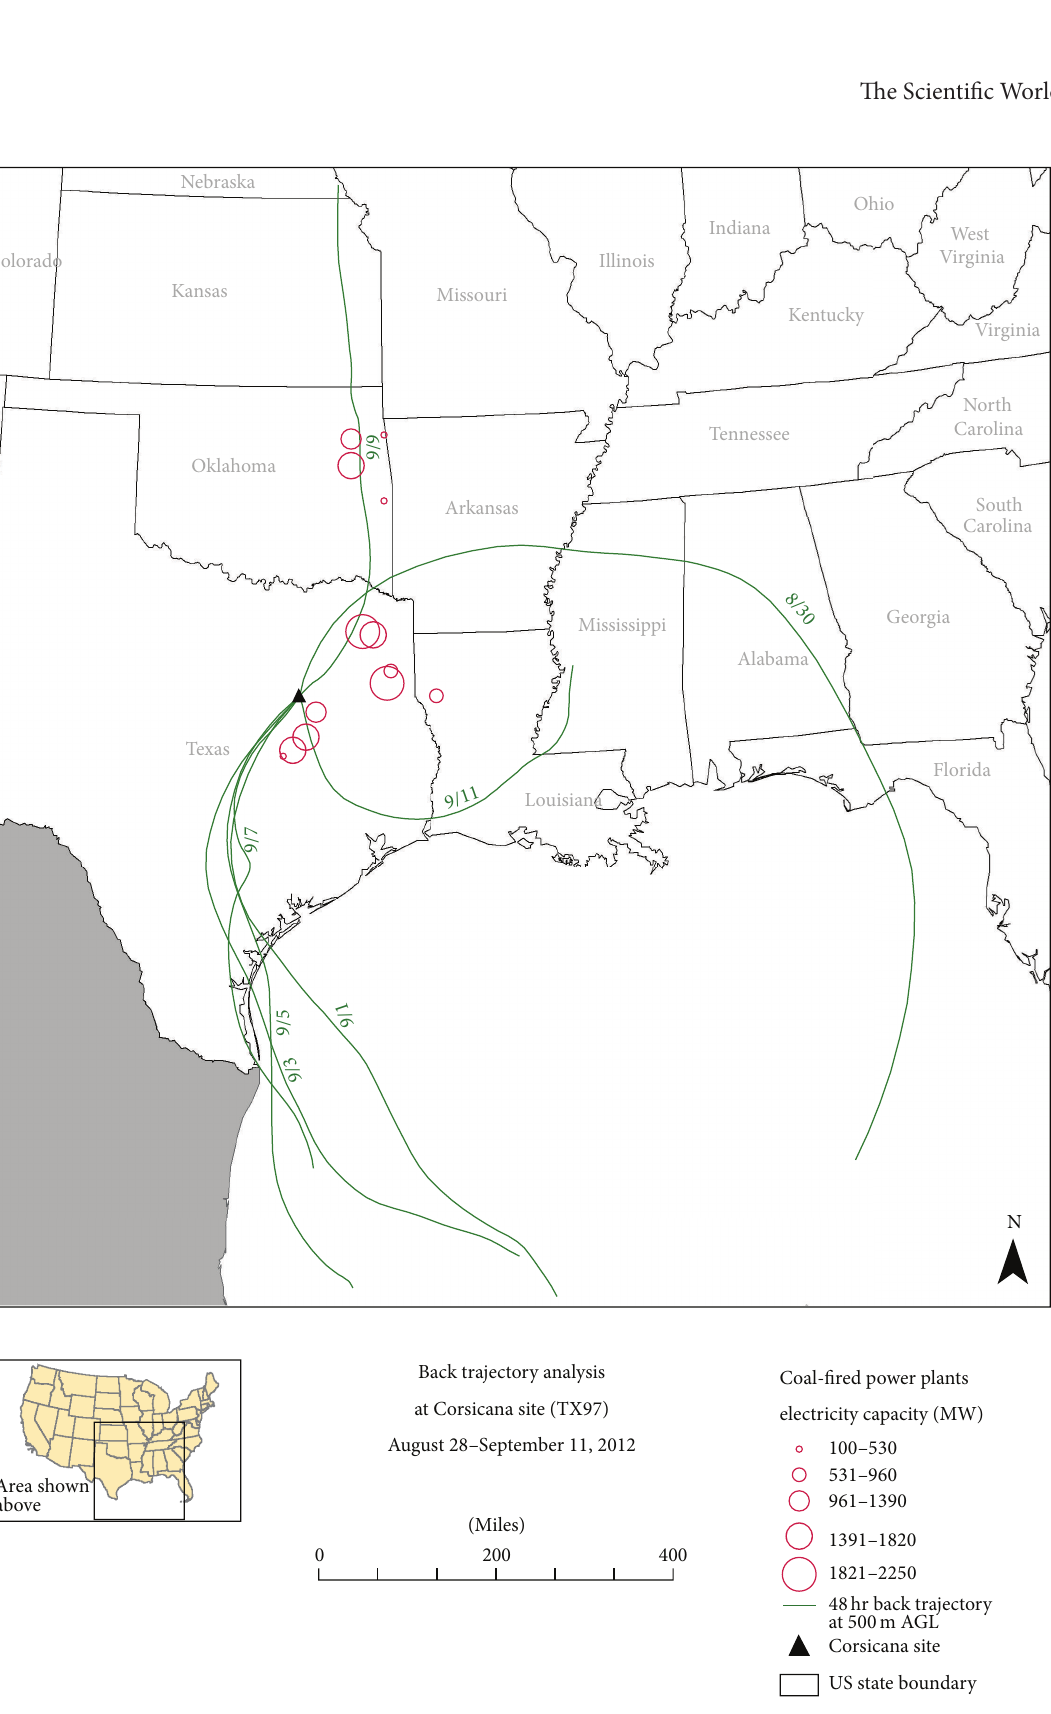
Figure 5: Back trajectory analysis for the Corsicana site (TX97) for August 28 to September 11, 2012. Seven contiguous 48-hour back trajectories ending at 1000 LST on September 11, 2012. End date of each 48-hour back trajectory plotted for each trajectory trace (e.g., 8/30 represents 48-hour back trajectory for 8/28–8/30). Coal-fired power plant locations are located at center of open